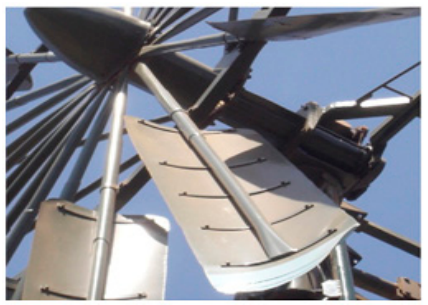
Figure 14. Windmill circular blade used in wind turbine, Fagbenro et al. [122].